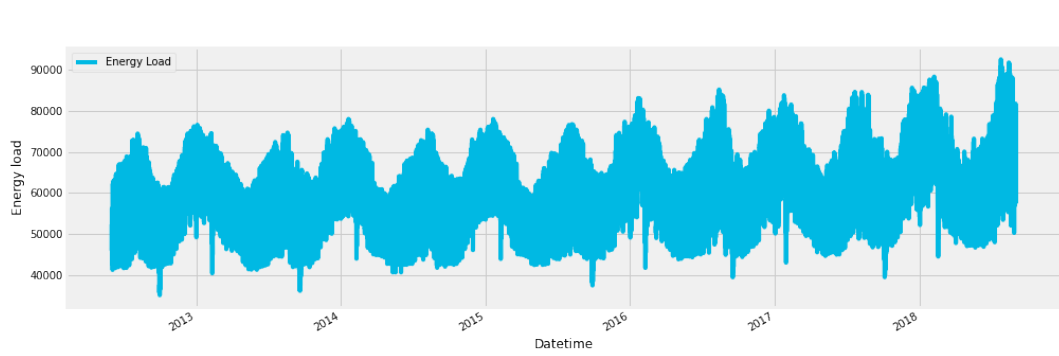
Figure 7. Full dataset after